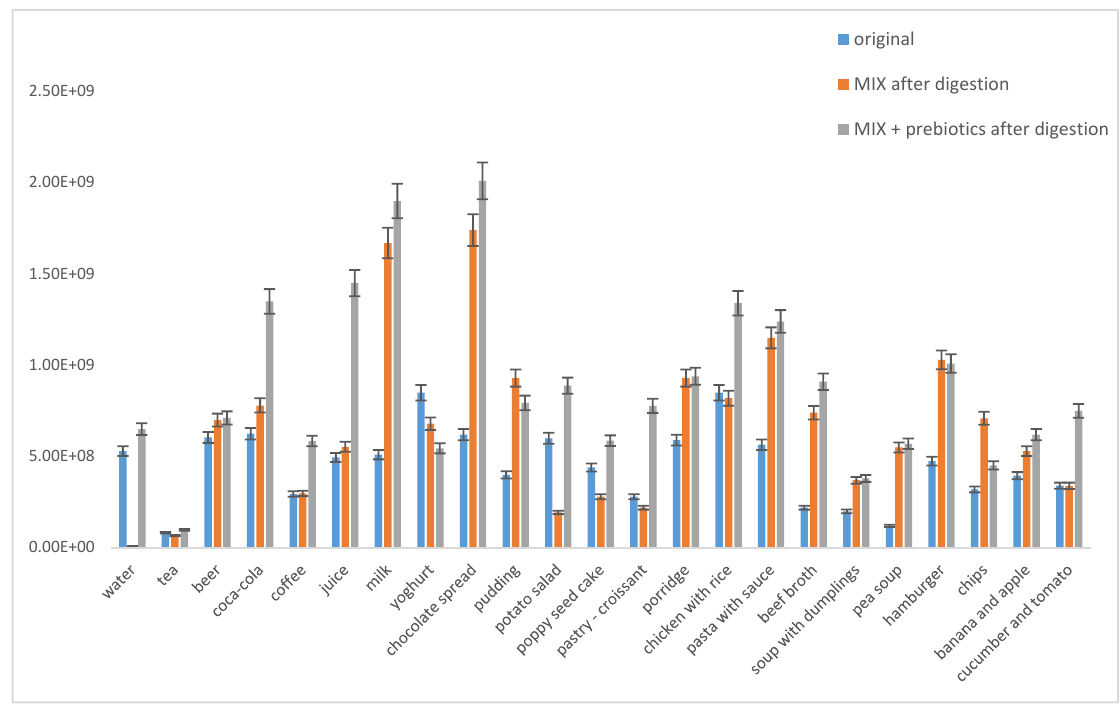
Figure 7. The effect of various foods and the addition of prebiotics (inulin) on the viability of probiotic cells in the mixed probiotic preparative (MIX).